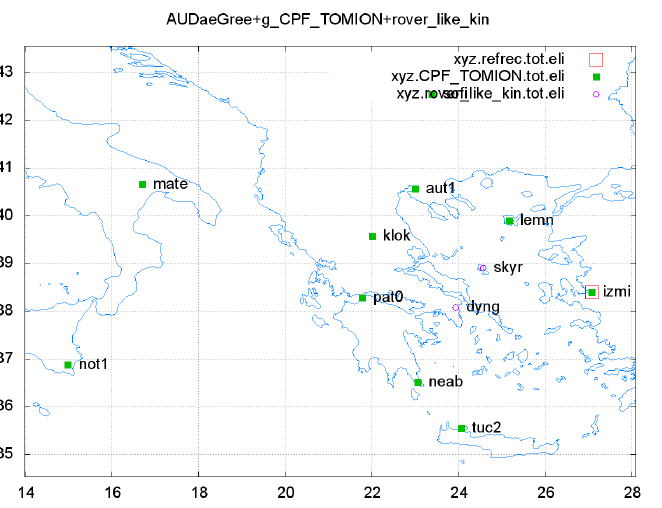
Figure 6. The baseline network of GNSS receivers used in the extensive WARTK study since 11 to 21 June 2018, where the permanent receivers DYNG and SKYR are treated as rovers, and the permanent receiver IZMI is taken as reference for